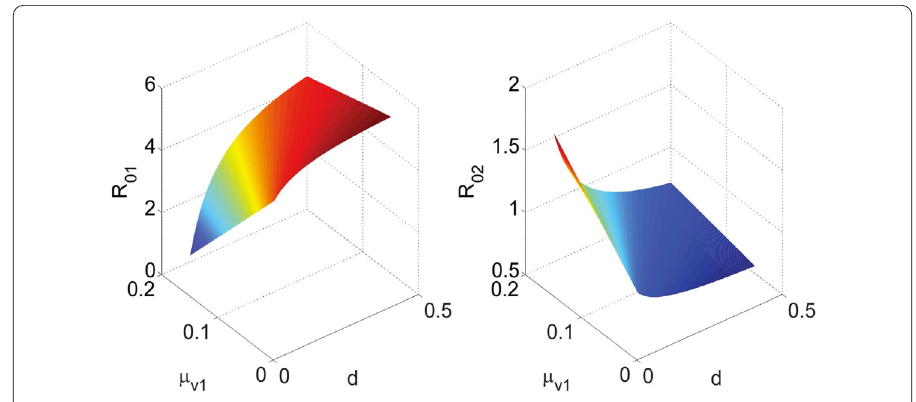
Figure 7 Surface plot of the basic reproduction numbers R 01 and R 02 as functions of μ v 1 and d for the parameters given in Example 5